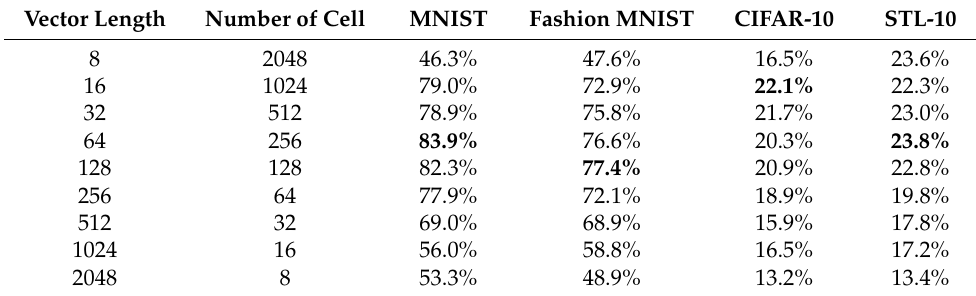
Table 1. Simulation result of image datasets with 16 KB of memory.